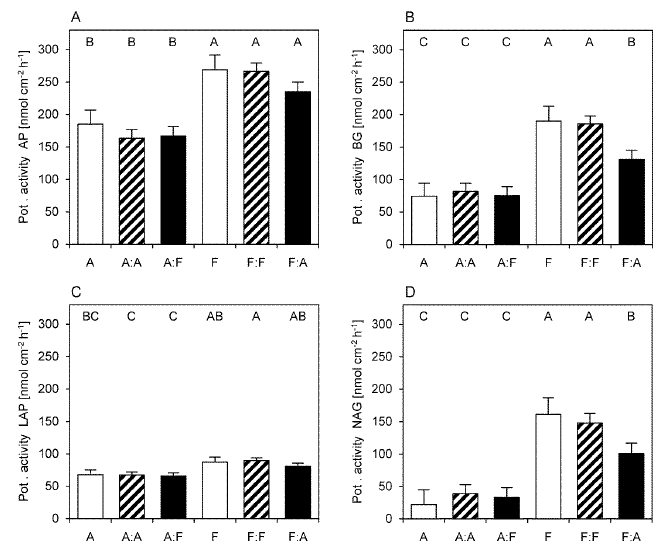
Figure 5. Potential enzymatic activities (PEA; nmol cm − 2 h − 1 ) of (A) acid phosphatase (AP), (B) β - glucosidase (BG), (C) leucine-amino-peptidase (LAP), and (D) N -acetyl-glucosaminidase (NAG) on